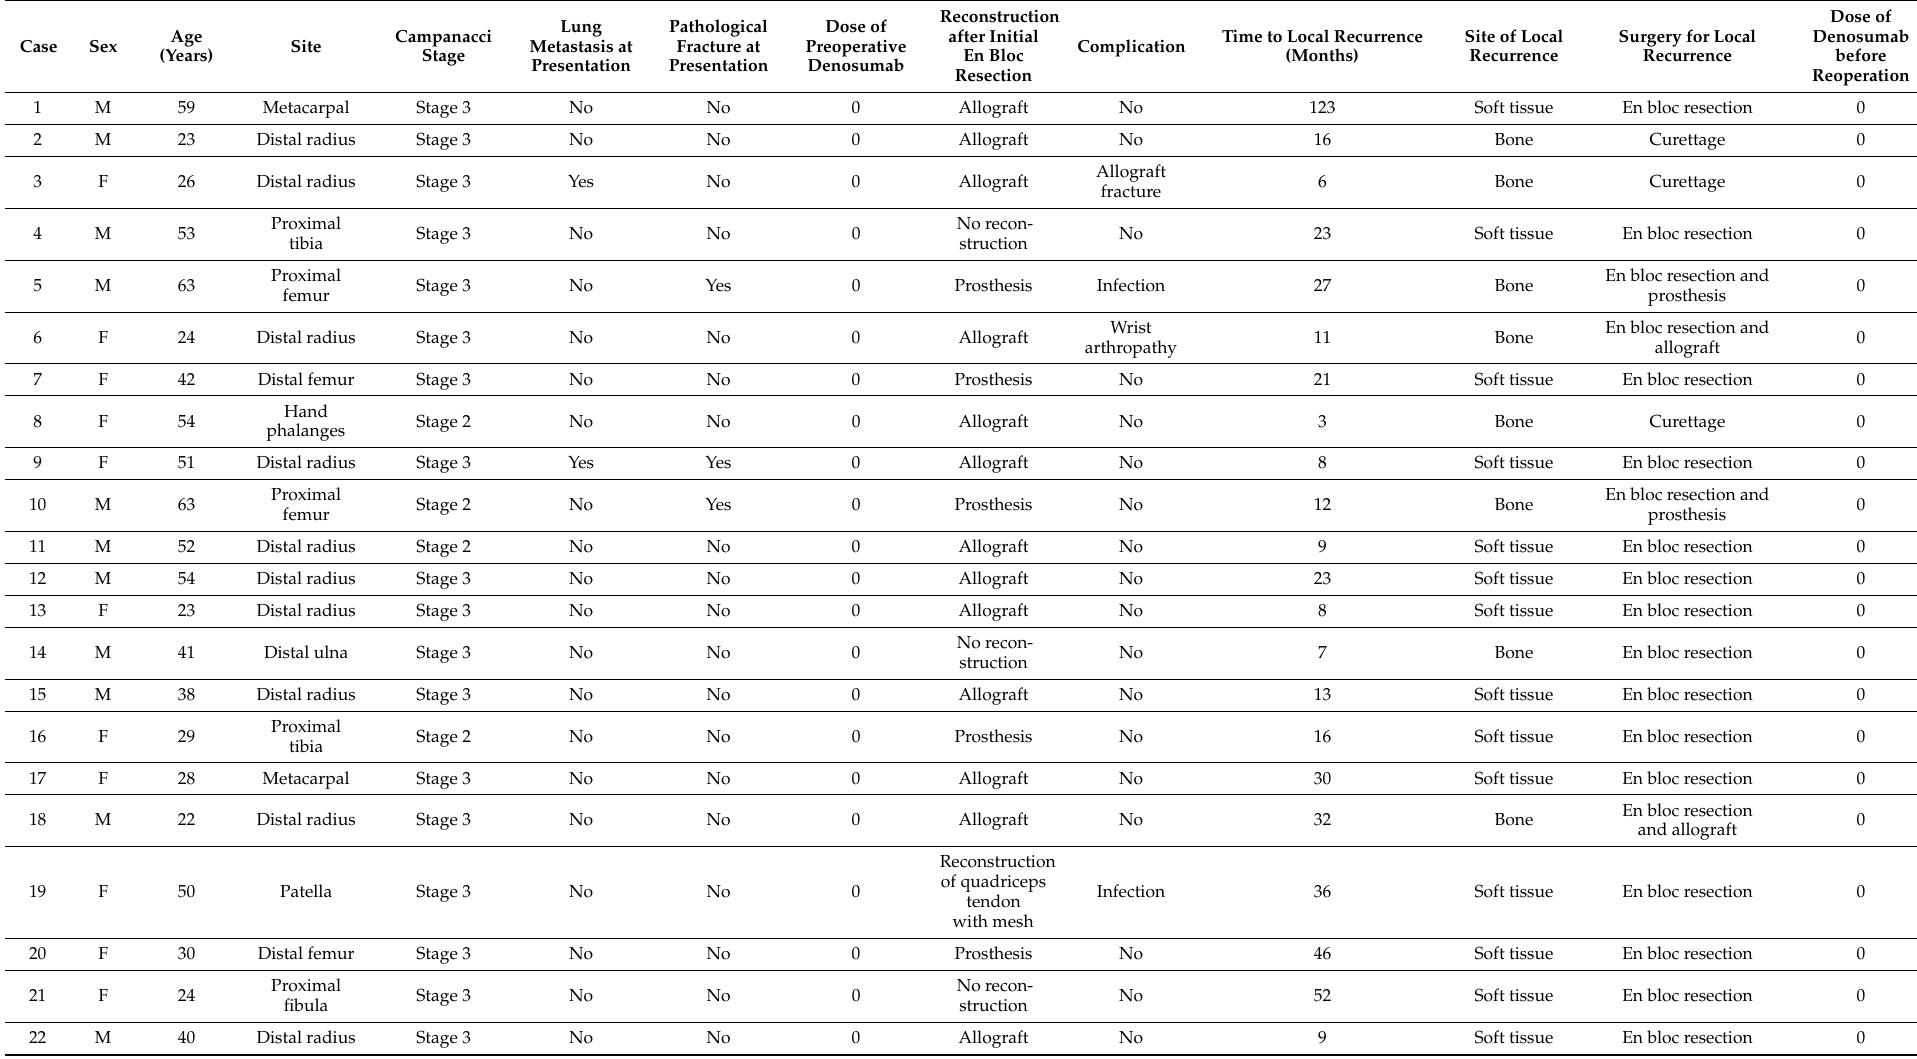
Table 3. Details of 29 patients with GCTB of the extremities who experienced local recurrence after en bloc